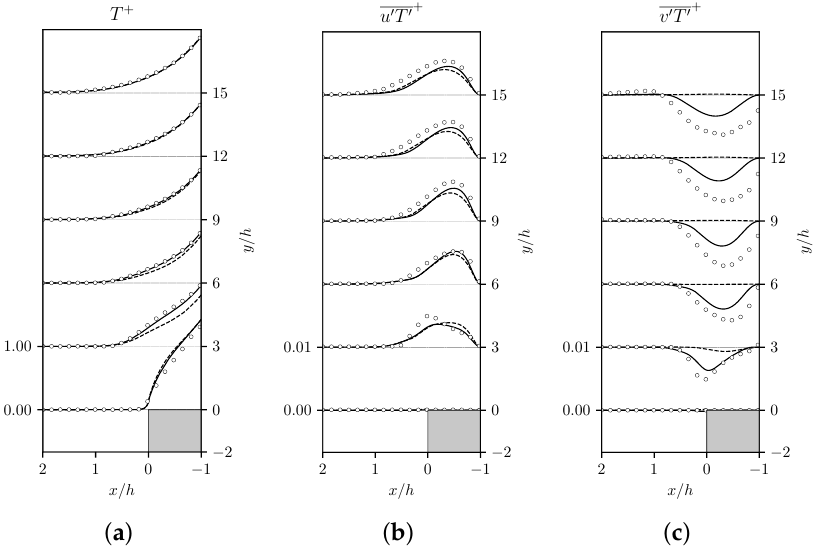
Figure 12. Profile of thermal fields: Mean temperature T + ( a ), mean wall-normal turbulent heat + flux u (cid:48) T (cid:48) ( b ), and mean streamwise turbulent heat flux v (cid:48) T (cid:48) anisotropic four-parameter (A4P) model; : Simulation results with the isotropic four-parameter (4P) model. : DNS ◦